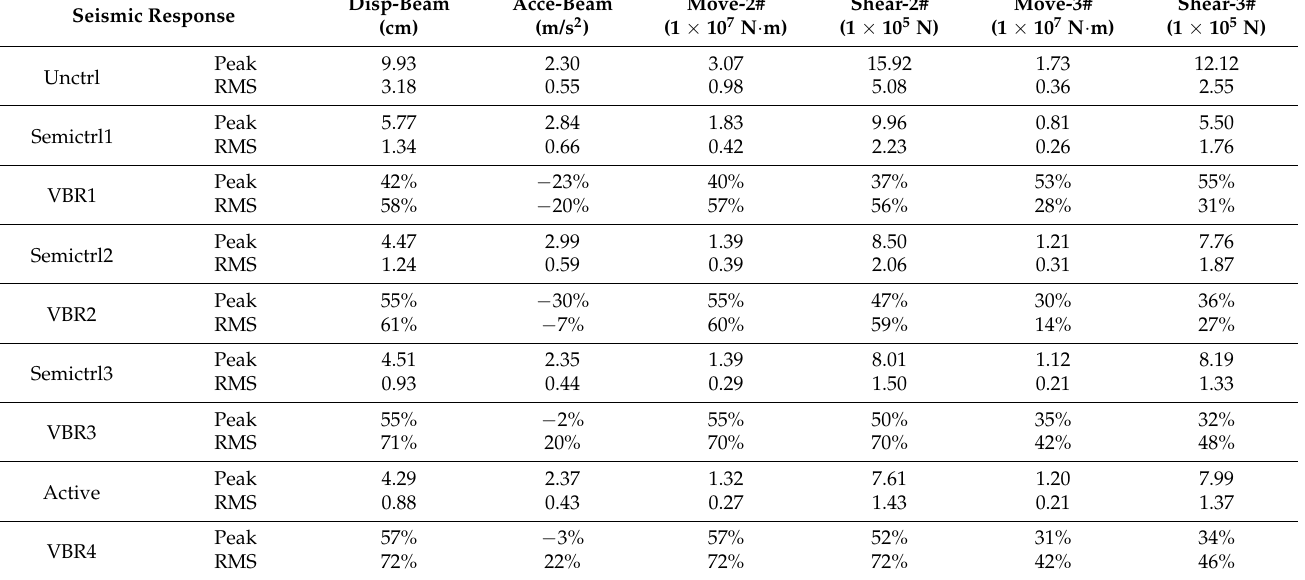
Table 4. Analysis of various semi-active vibration absorption effects (peak and